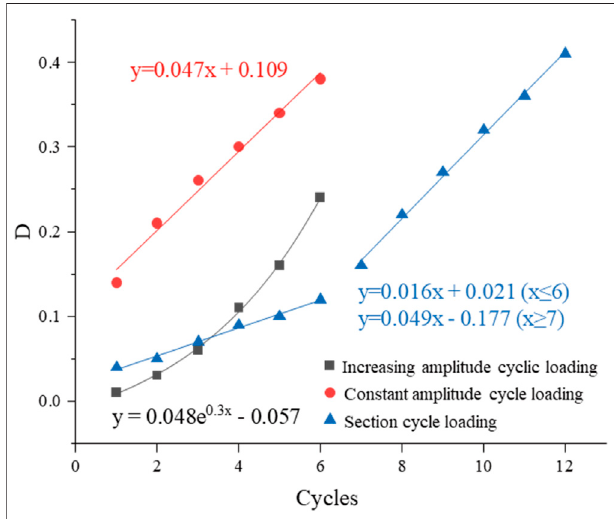
FIGURE 13 | The relationship between the damage and cycle loading and unloading